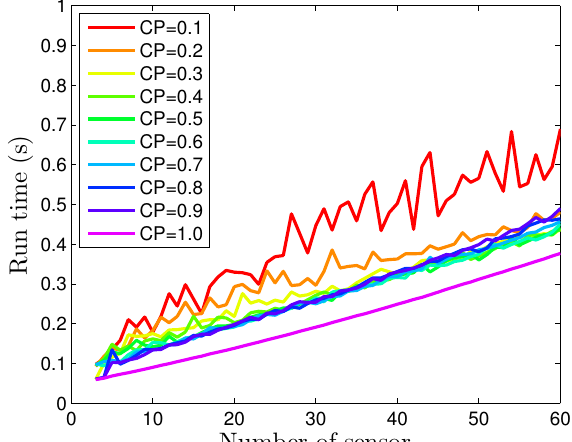
Figure 18. The mean values of the run times with different sensor